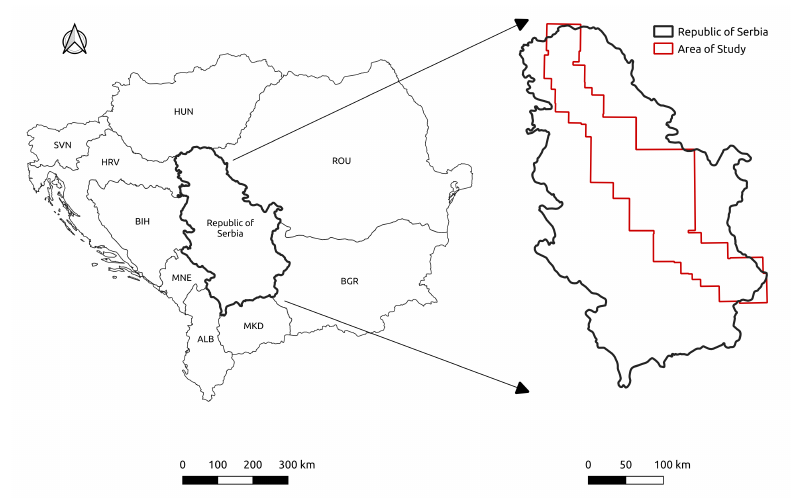
Figure 5. The geographical area of our study in Serbia.